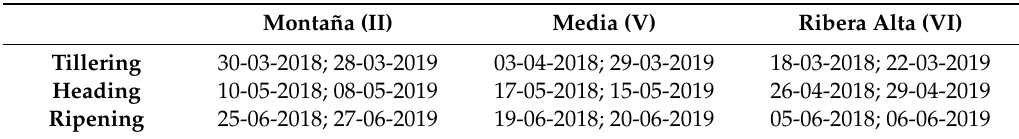
Table 2. Estimated phenological day of year regarding GDD average (Table 1) for the seasons analyzed (2018 and 2019).